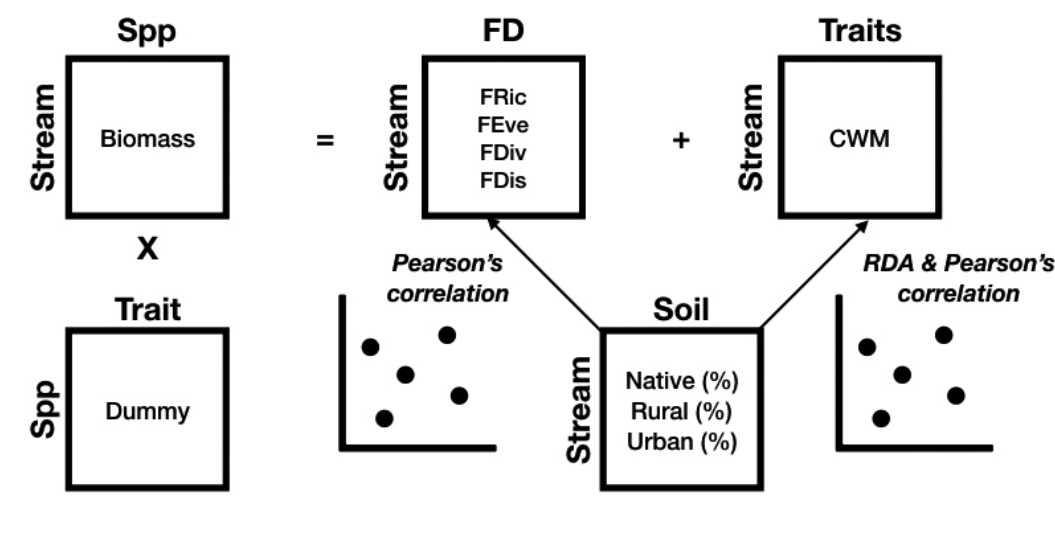
FIGURE 3 | Flowchart of analysis. Biomass and dummy traits matrices were combined to produce functional diversity (FD) indices (FRic = functional richness, FEve = functional evenness, FDiv = functional divergence and FDis = functional dispersion) and community weight mean traits (CWM) matrices. The influences of land use/occupation (Soil matrix) over FD indices were evaluated through Pearson’s correlations and over CWM through redundance analysis (RDA) and Pearson’s